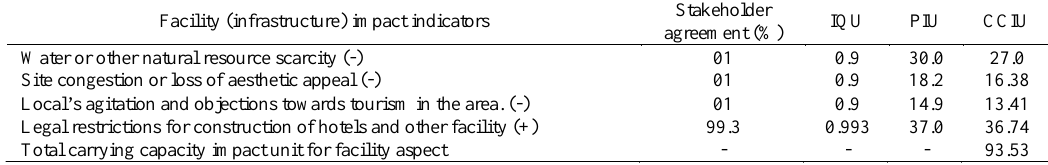
Table 6: Indicator quality unit and carrying capacity impact unit of facility carrying capacity component